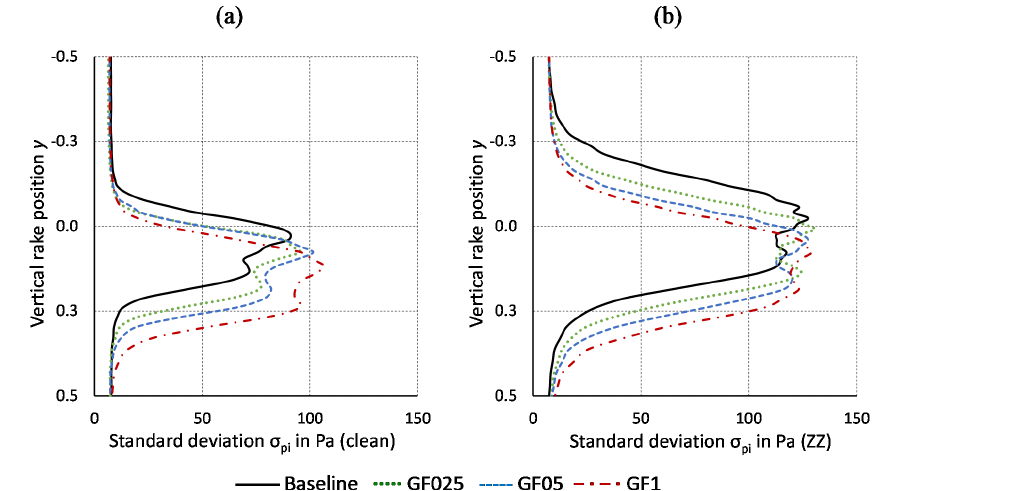
Figure 10. NACA63(3)618 at α = 6 . 4 ◦ . Gurney flaps. Standard deviation of raw pressure data over vertical wake rake positions. (a) Clean case. (b) Tripped